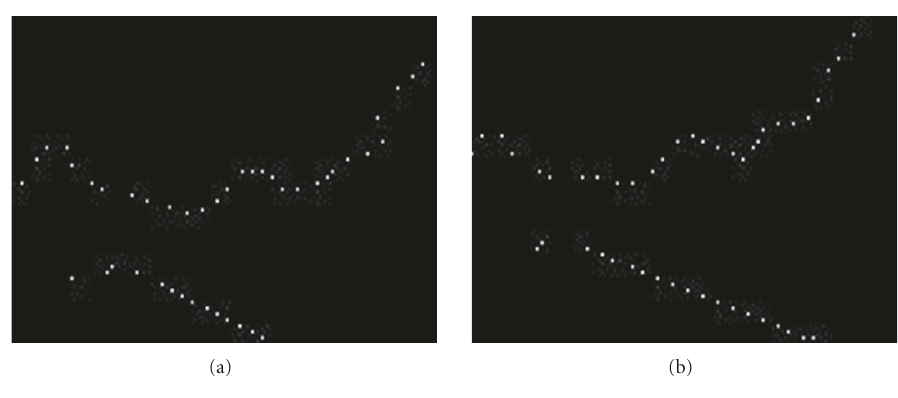
Figure 3: Feature point sets extracted from two neigboring